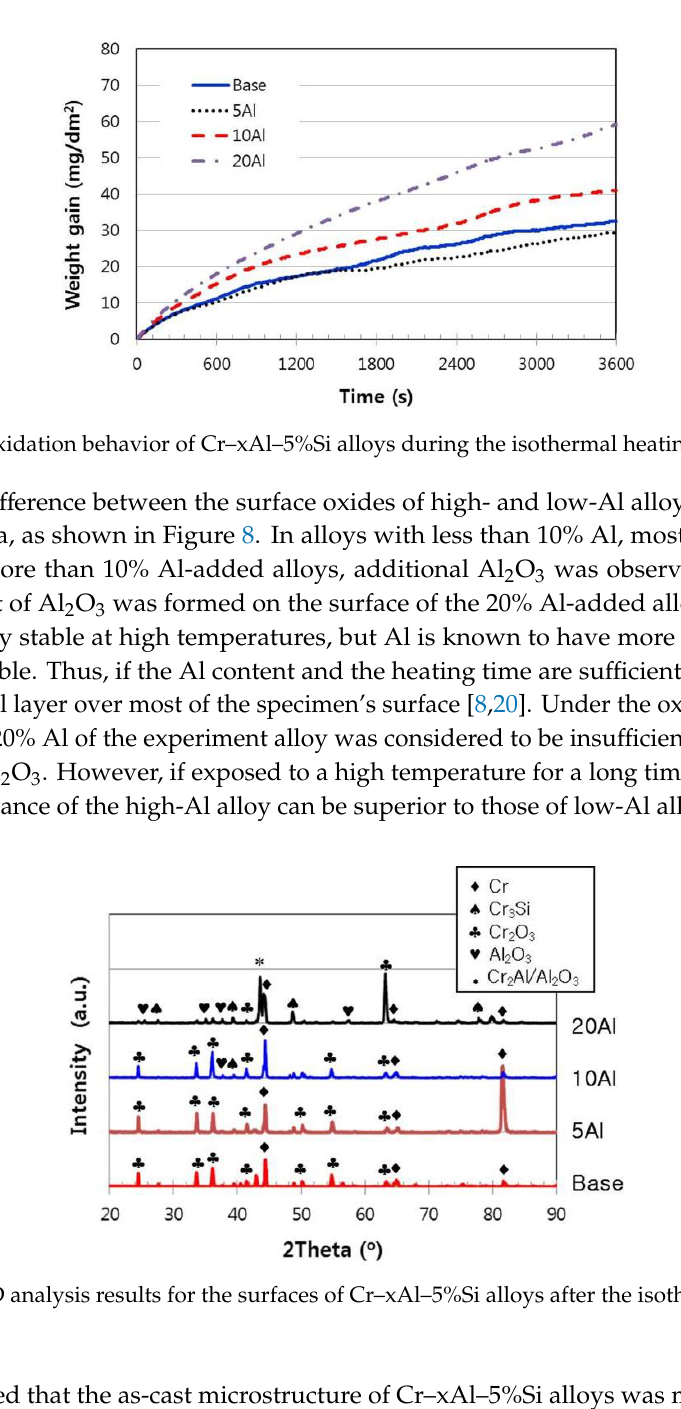
Figure 8. XRD analysis results for the surfaces of Cr–xAl–5%Si alloys after the isothermal heating .